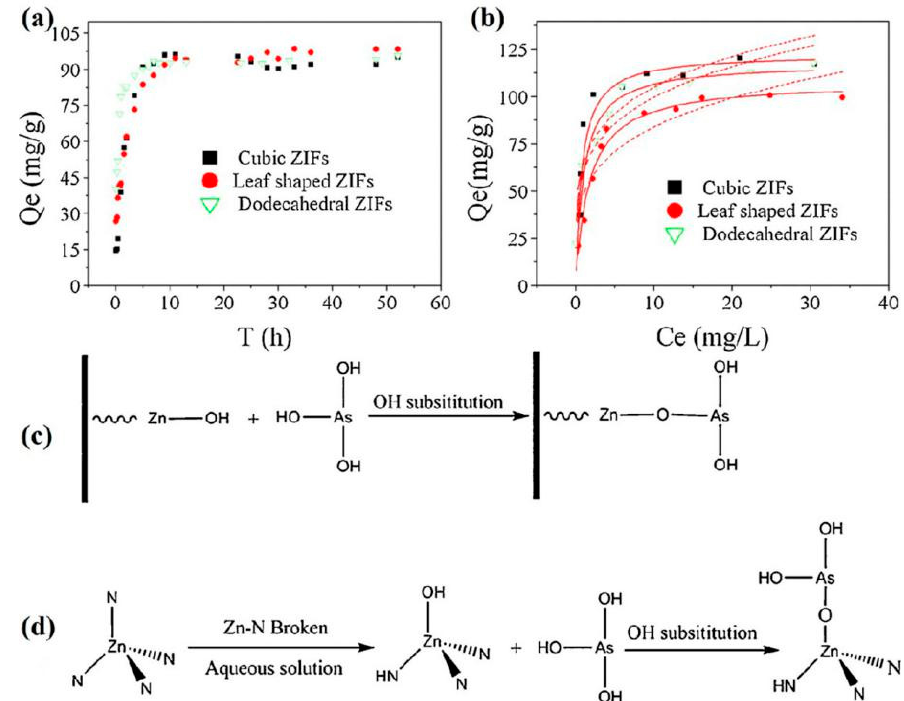
Figure 2. As(III) adsorption ( a ) kinetics (initial arsenic concentration of 35.4 mg L − 1 ) and ( b ) isotherms (initial arsenic concentration of 5–70 mg L − 1 ) for the three zeolitic imidazolate framework (ZIF) structures. The solid line represents the Langmuir fitting curve, dotted line represents the Freundlich fitting curve; ( c , d ) show the proposed pathway for As(III) adsorption on ZIFs. Reproduced with permission from [46]. Copyright Elsevier, 2015.